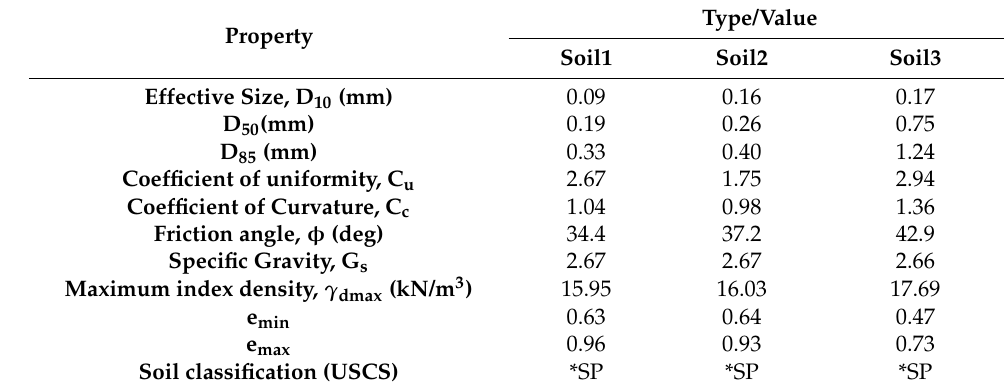
Figure 1. Particle size distribution of various sands used in the study. Table 1. Properties of soils used in this study.